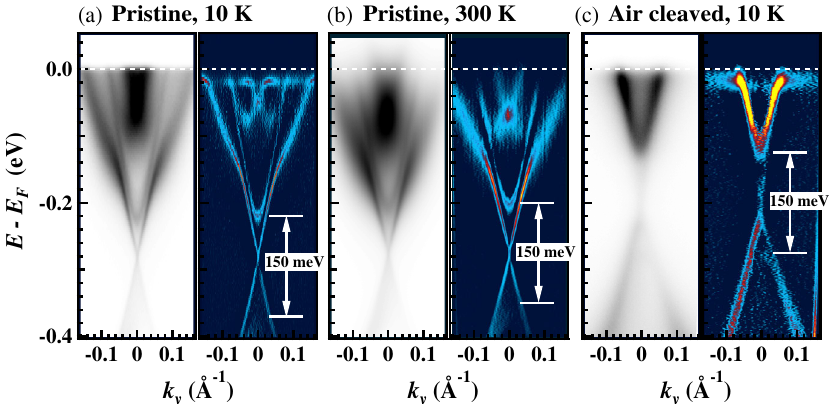
FIG. 3. Robustness of the Dirac surface state. ARPES raw (left) and second derivative (right) k - E maps taken with 6.3 eV laser light ¯ Γ ¯ K ¯ K ) for (a) a pristine sample cleaved and measured at 10 K (below T along - - ( k y 300 K (well above T ), and (c) a sample cleaved in air at room temperature, and measured at 10 K. Despite the overall carrier doping N induced by different cleaving conditions, the gapless Dirac cone is clearly seen for all cases, along with an unchanged bulk band gap sized 150